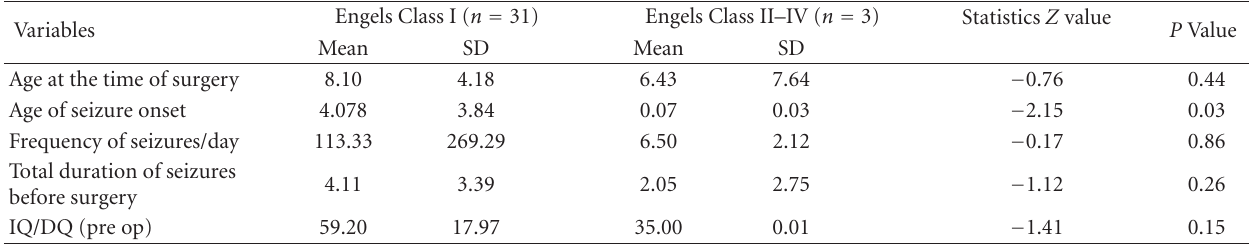
Table 2: Presurgery predictors of age, seizures, and cognition on postsurgery seizure outcome.